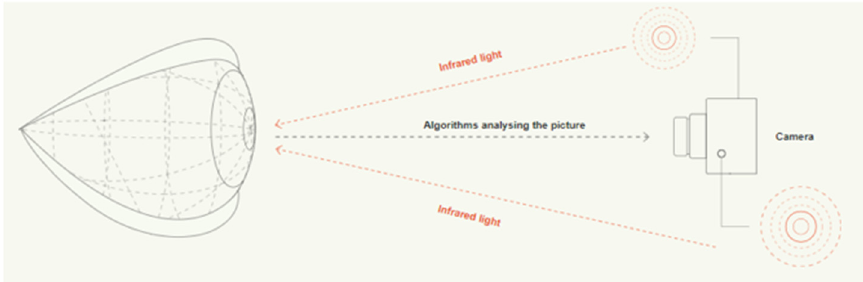
Figure 11. Eye tracking system based on a camera and LED lights.